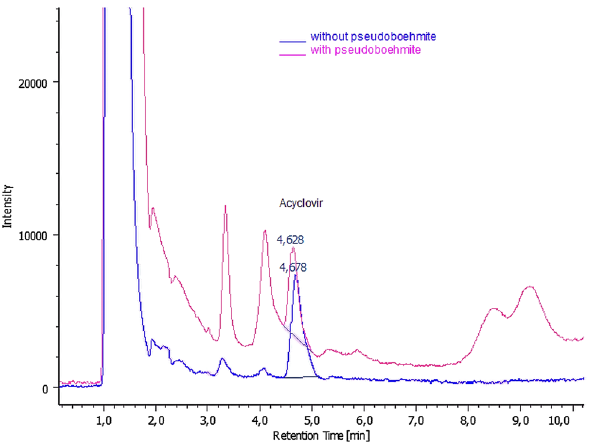
Figure 13. Chromatograms of serum samples of Wistar rats treated without (blue) and with pseudoboehmite (magenta).